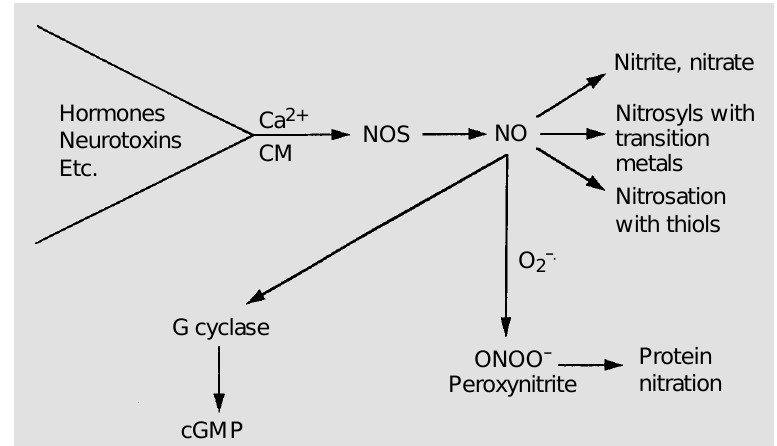
Figure 6 - Fate of nitric oxide (NO). NOS, NO synthase.